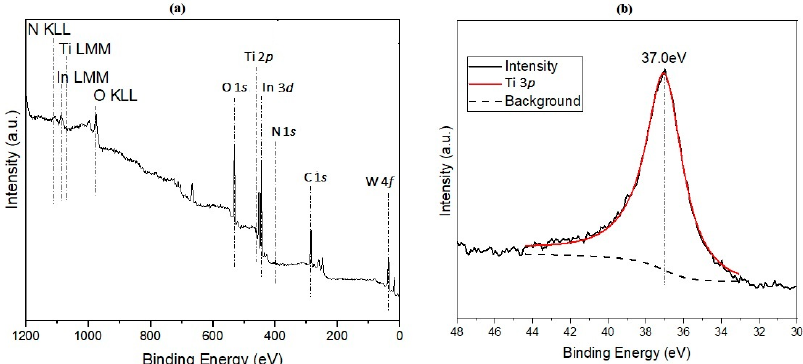
Figure 1. ( a ) XPS survey spectrum of 50% TiBALDH fibers and ( b ) Ti 3 p XPS spectrum of 100% TiBALDH fibers. Nanomaterials 2021 , 11 , x FOR PEER REVIEW